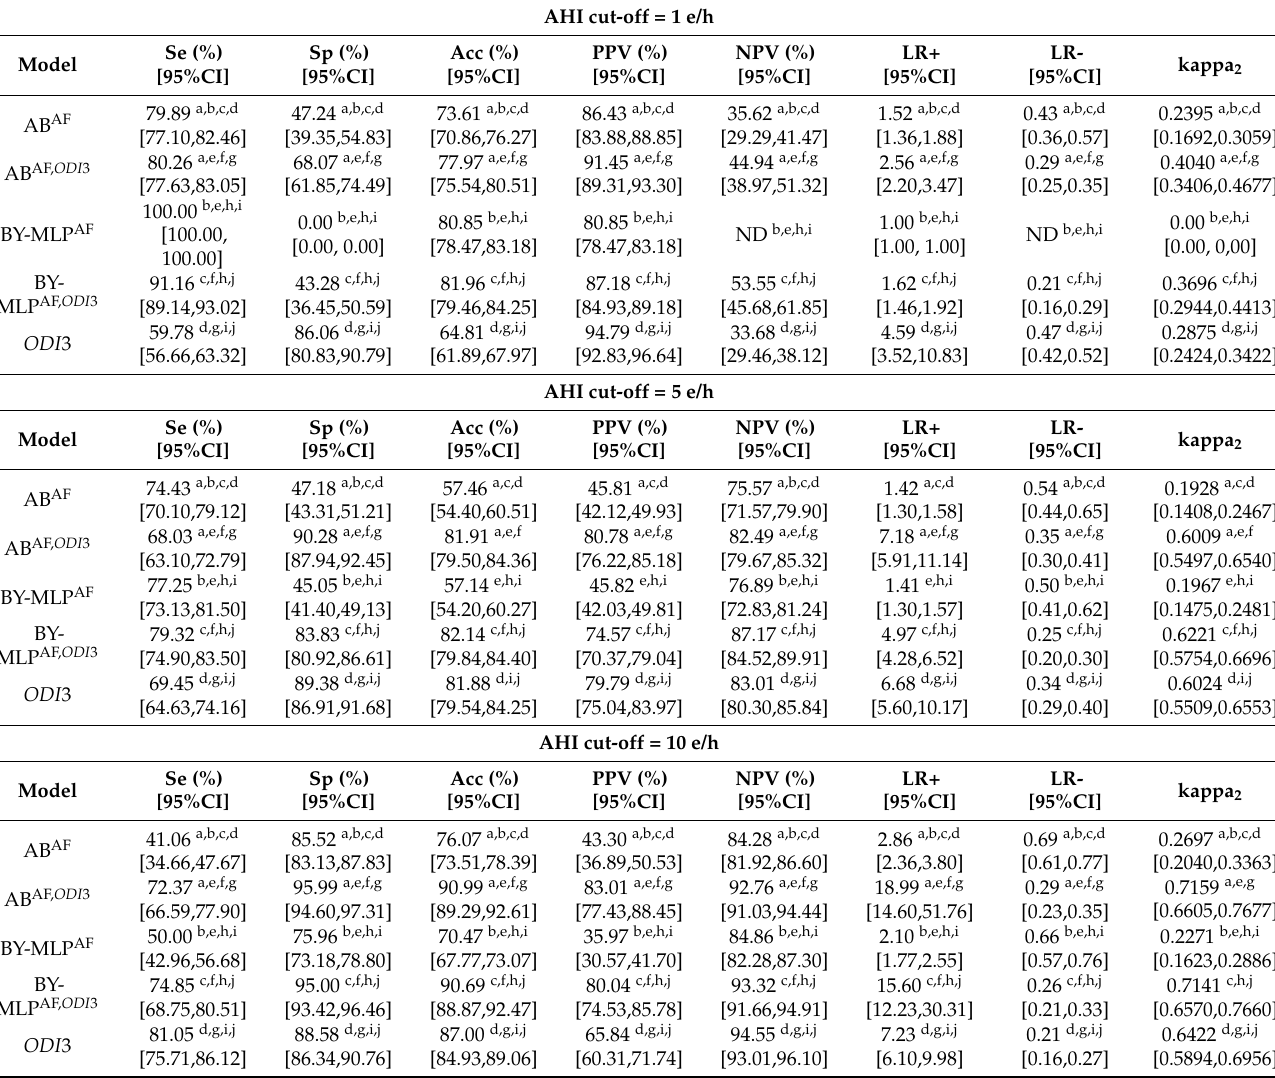
Table 3. Diagnostic evaluation of the proposed models and ODI